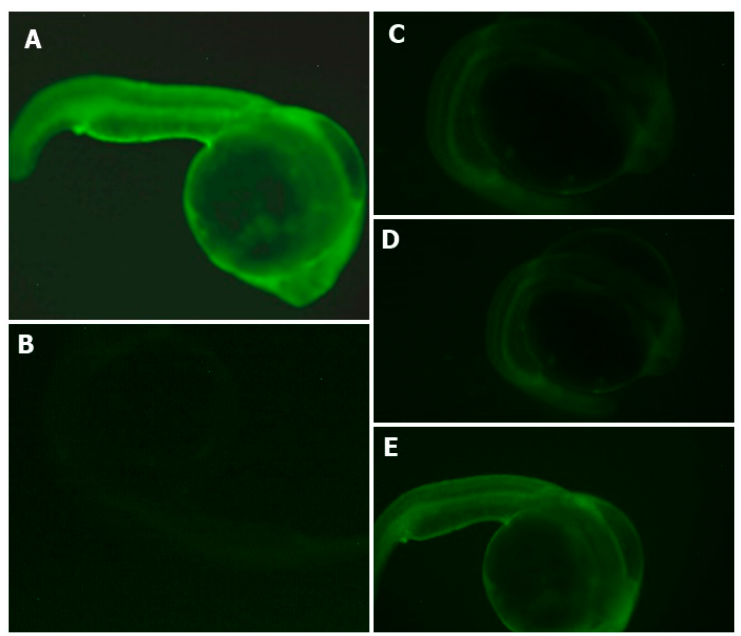
Figure 5. Effects of APC hydrolysates against AAPH-induced oxidative stress (ROS) in the zebrafish embryo model. ( A ) AAPH-treated group, ( B ) Non-treated group, ( C ) Gastric hydrolysate of APC at pH 2.0 and ( D ) intestinal hydrolysate of APC and ( E ) APC (amaranth protein concentrates without hydrolysis).